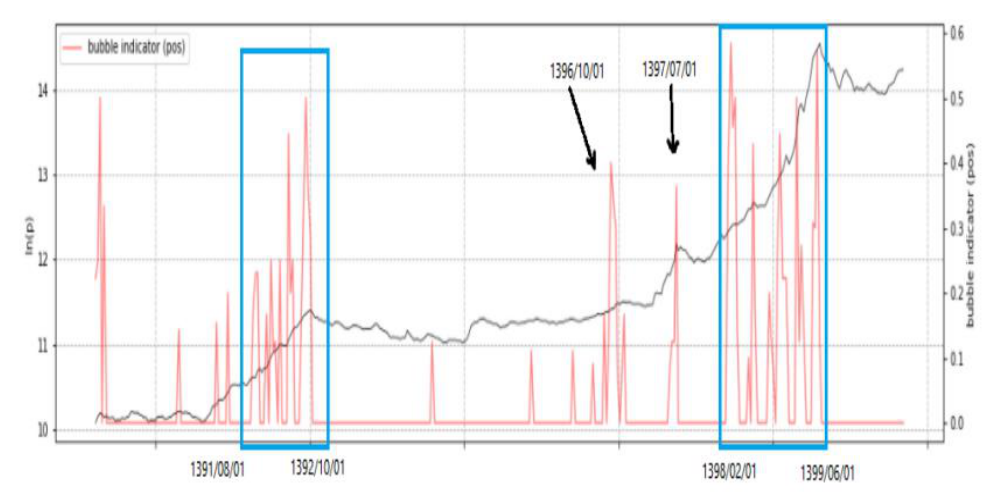
Figure 3, a mid-term indicator of TEDPIX